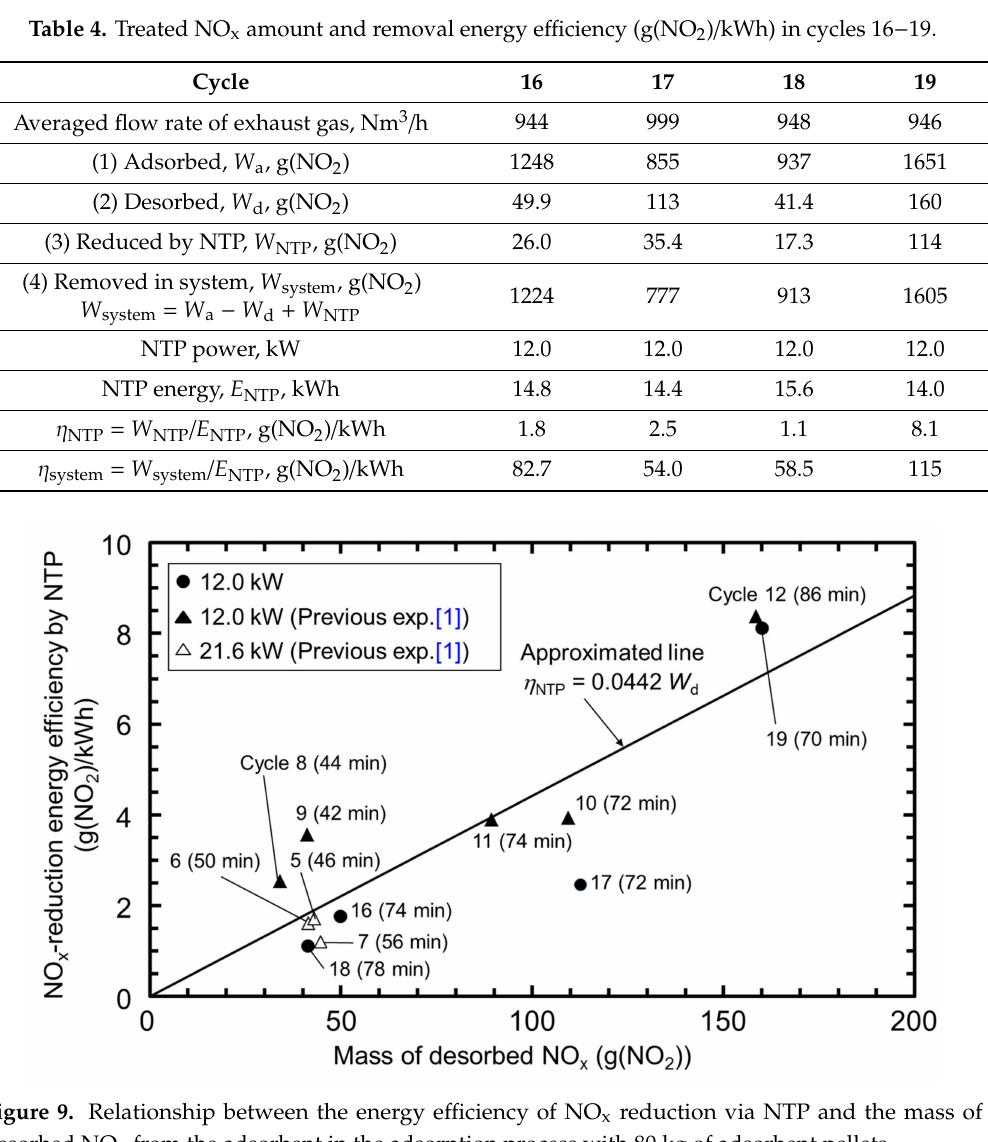
Figure 9. Relationship between the energy e ffi ciency of NO x reduction via NTP and the mass of desorbed NO x from the adsorbent in the adsorption process with 80 kg of adsorbent